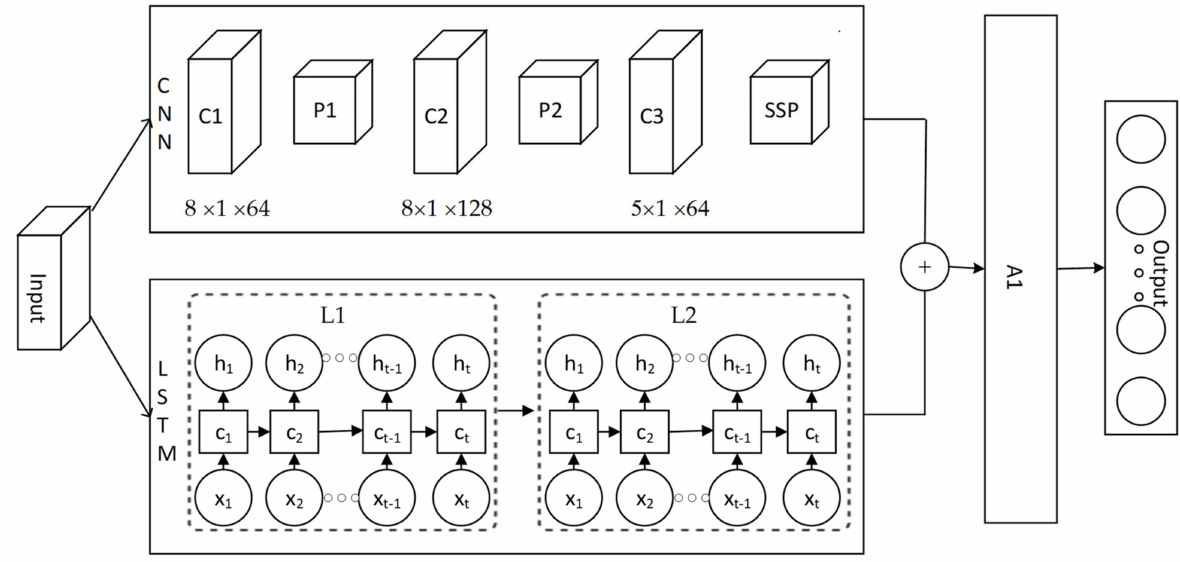
Figure 4. The framework of